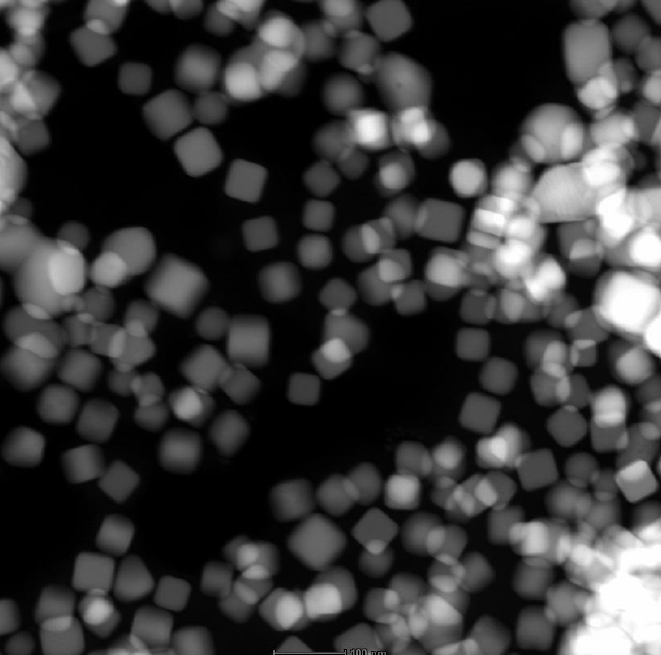
Figure S1. STEM image of the silver